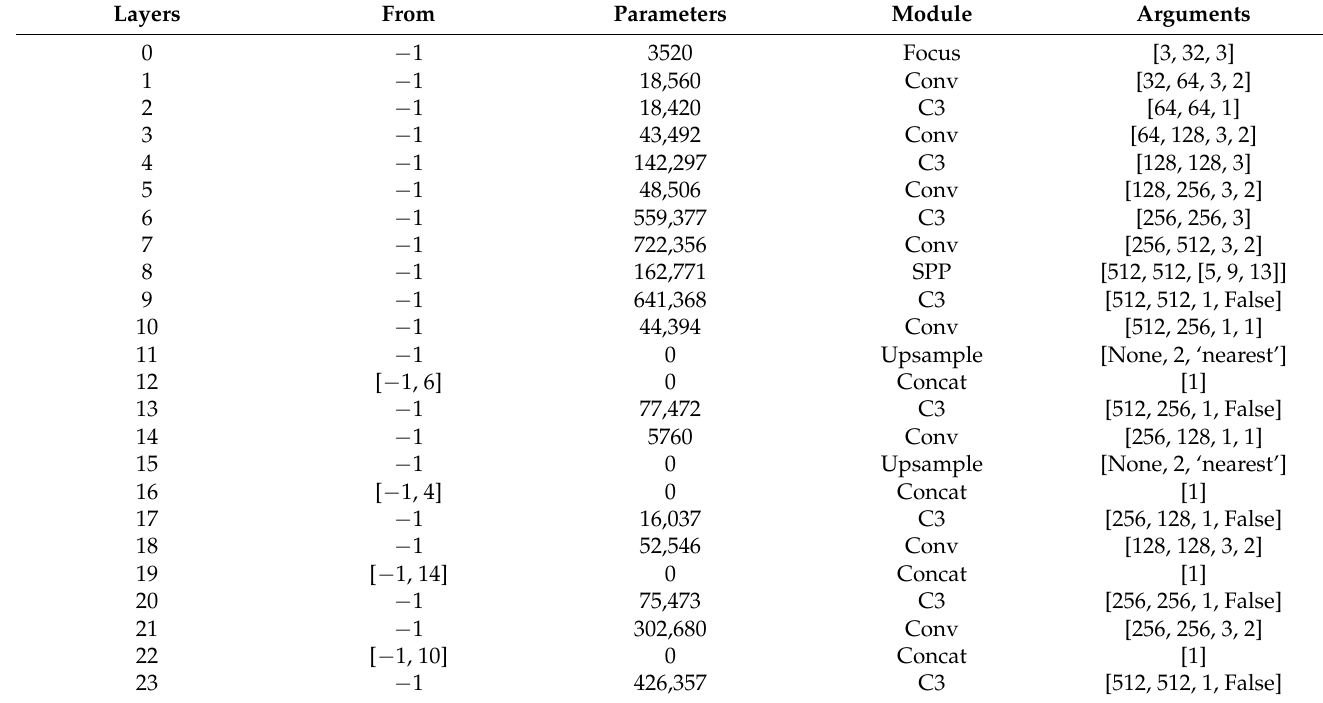
Table 6. Pruned network parameters.